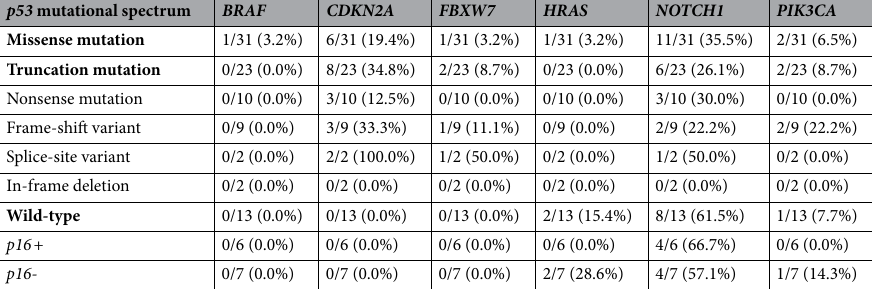
Table 2. Relationship between the p53 mutational spectrum and mutations of oncogenic driver genes in OSCC. *Counting of double mutations: Missense + Truncation (Splice-site variant) → Truncation (Splice-site variant); Truncation (Nonsense) + Truncation (Splice-site variant) → Truncation (Nonsense); Missense + Missense → Missense.